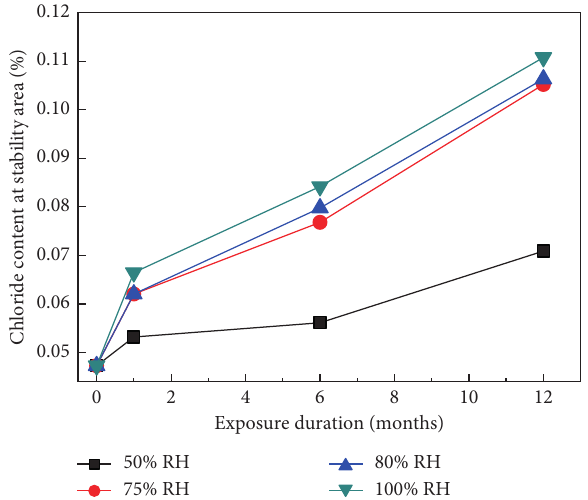
Figure 8: Balanced chloride content in concrete subjected to various external RH